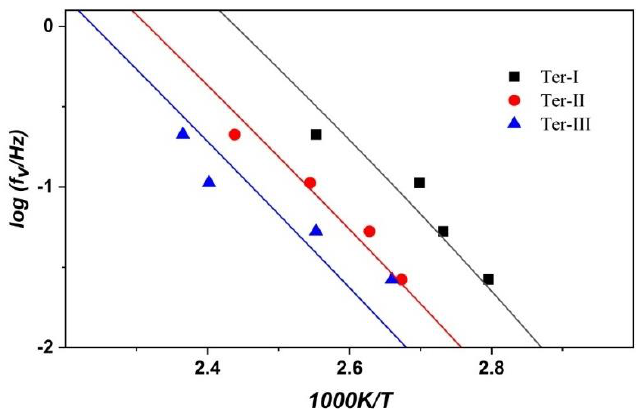
Figure 5. Activation curves of the three terpolymer samples as evaluated from the DSC thermograms measured at four different heating rates.